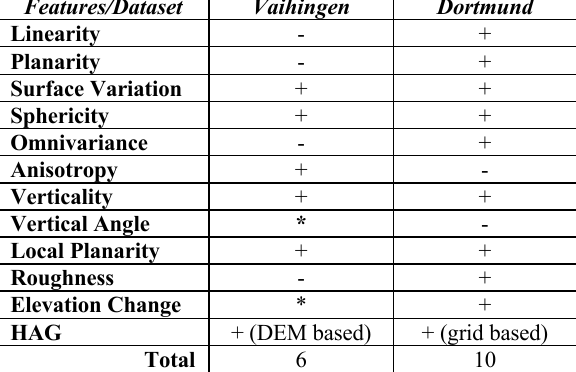
Table 1. Sets of features used for each dataset (+ means used, - means not used) for classification, * means used only during DEM extraction).